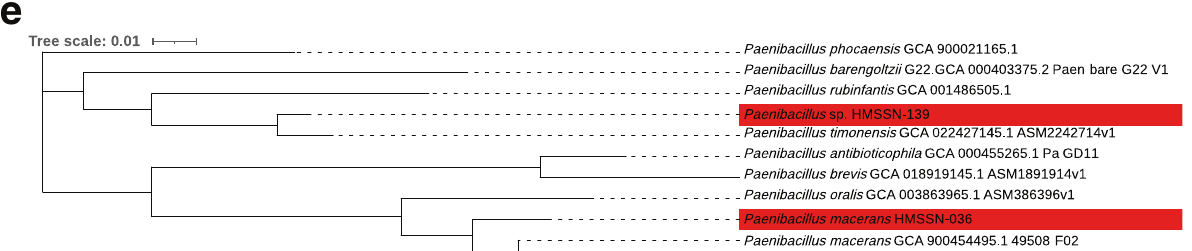
demonstrated to be positive (Fig. S14). Therefore, the genes detected in isolated Paenibacillus strains could be functional for nitrogen fi xation, auxin production, siderophore reaction, and phosphate solubilization in the bacterium. These results suggest that compost-derived Paenibacillus strains may exhibit PGPR effects.